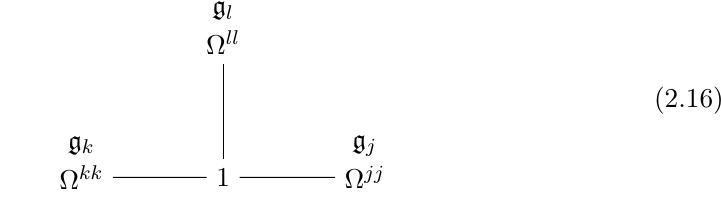
is a subalgebra of e . Correspondingly, the adjoint representation of e 8